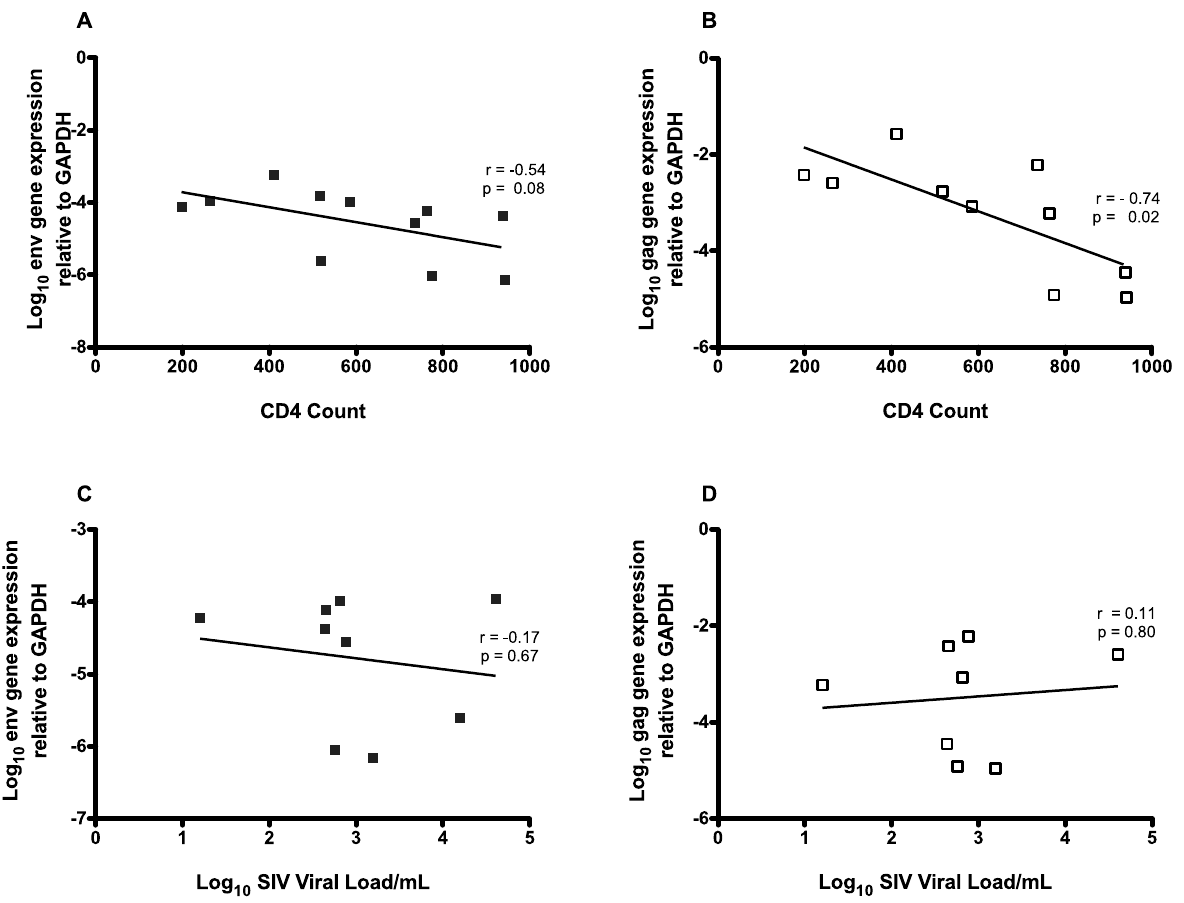
Figure 5. CyERV gene expression negatively associated with CD4 + T-cell counts and SIV viral load. During acute SIV infection, CyERV envelope (n=11) and gag (n=10) gene expression levels negatively correlated with CD4 + T-cell counts (CD4 + T-cells/ul of PBMCs) (A-B) and negatively associated with acute SIV viral load for CyERV envelope (n=9) (C). CyERV gag (n=8) expression showed a slight trend towards a positive association with acute SIV viral load (D). Bivariate correlations were performed using Pearson’s correlation coefficient (r), statistical significance values (p) are shown.